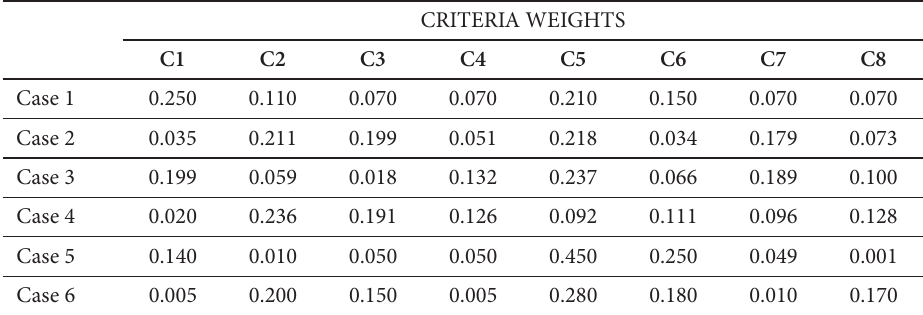
Table 10. Criteria weights of six different